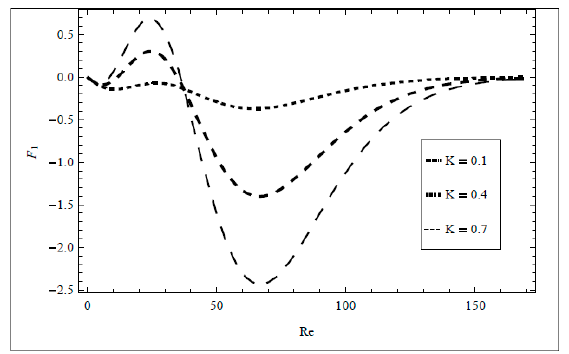
Figure 11. Effect of α on F 1 along Re at K = 0.1. Figure 11. E ff ect of α on F